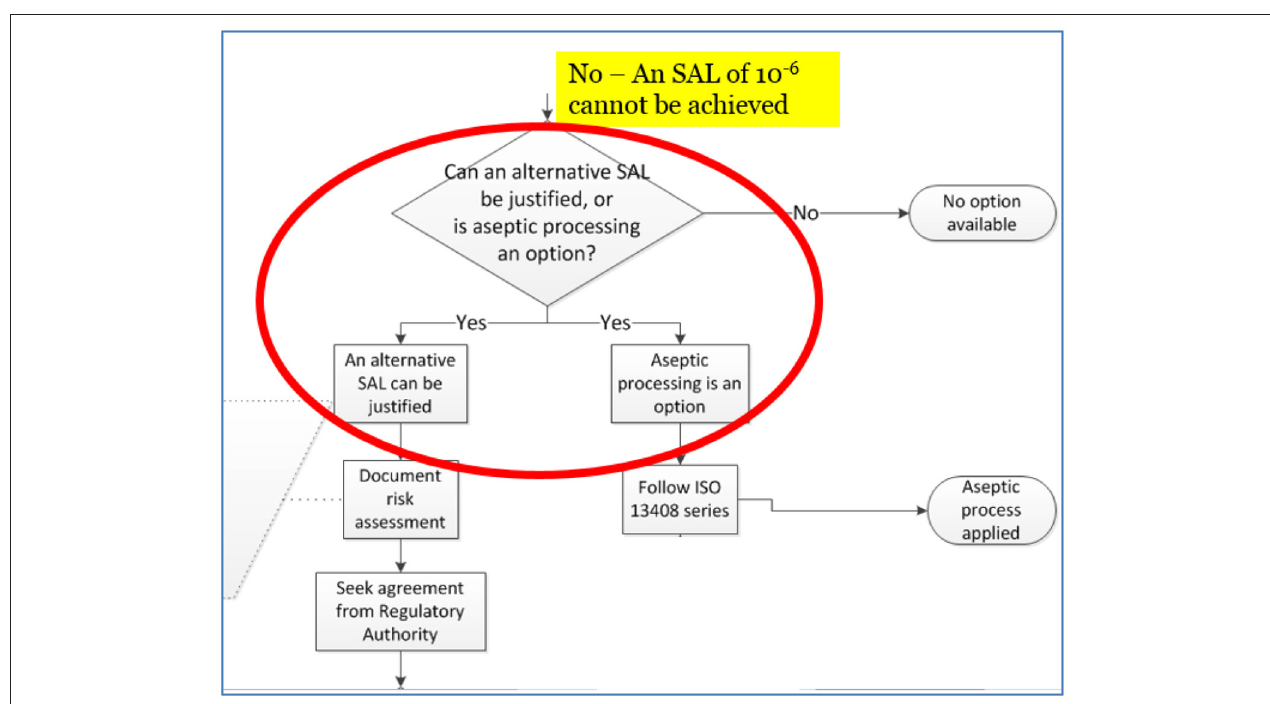
FIGURE 1 | Excerpt from Figure A.1 of ISO/TS 19930:2017, illustration of the sequence of activities in selecting and justifying an SAL > 10 − 6 , e.g., 10 − 4 .